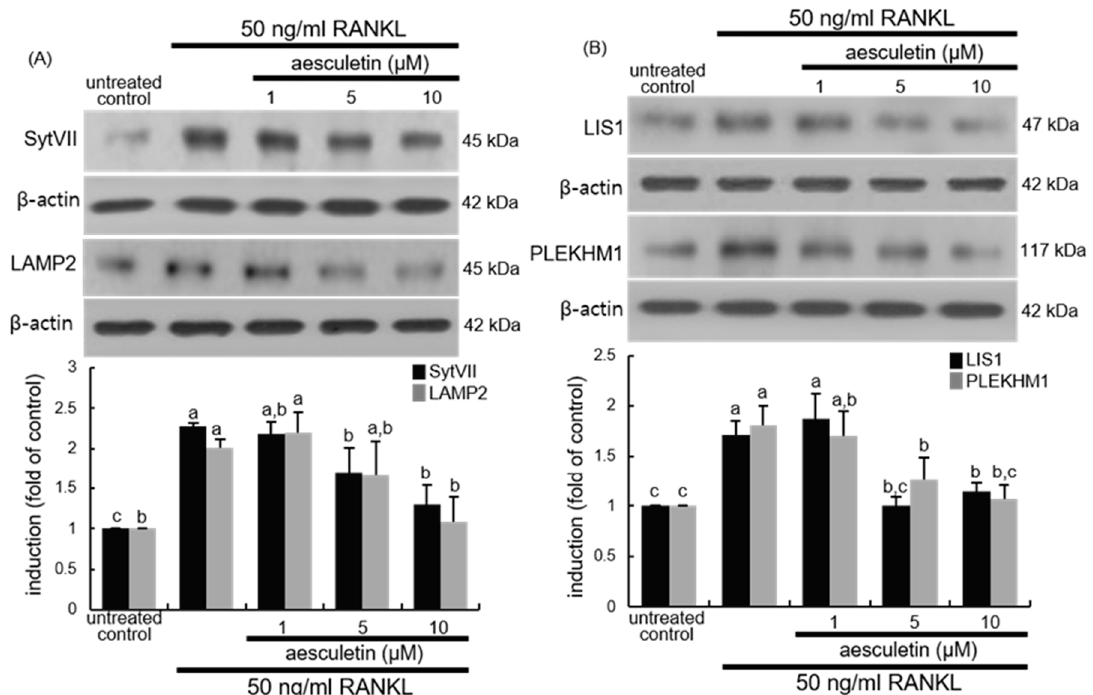
Figure 6. Western blot data showing inhibition of induction of synaptotagmin VII (SytVII), lysosome-associated membrane protein 2 (LAMP2), lissencephaly-1 (LIS1), and Pleckstrin homology domain-containing protein family member 1 (PLEKHM1) ( A , B ). Raw 264.7 cells were cultured in minimum essential medium alpha medium ( α -MEM) with 50 ng / mL receptor activator of nuclear factor- κ B ligand (RANKL) in the absence or presence of 1–10 µ M aesculetin for 5 days. Whole-cell lysates were subject to sodium dodecyl sulphate-polyacrylamide gel electrophoresis (SDS-PAGE) and Western blot with a specific antibody against SytVII, LAMP2, LIS1, and PLEKHM1. β -Actin was used as internal control. The bar graphs (mean ± SEM, n = 3) represent quantitative results of blots obtained from a densitometer. Respective values in double-bar graphs not sharing a small letter are significantly different at p < 0.05.